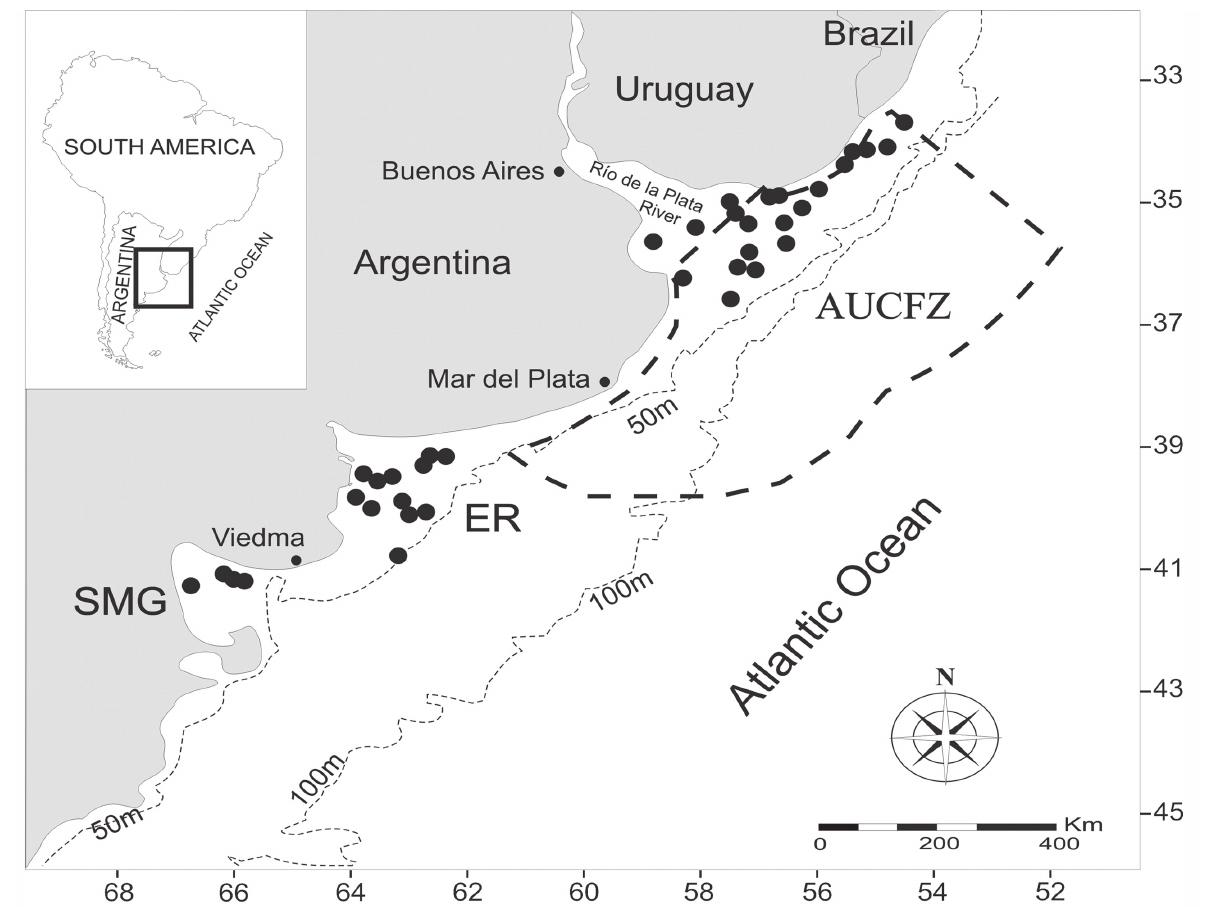
Fig. 1. Sampling sites of the Brazilian flathead, Percophis brasiliensis , in the southwestern Atlantic